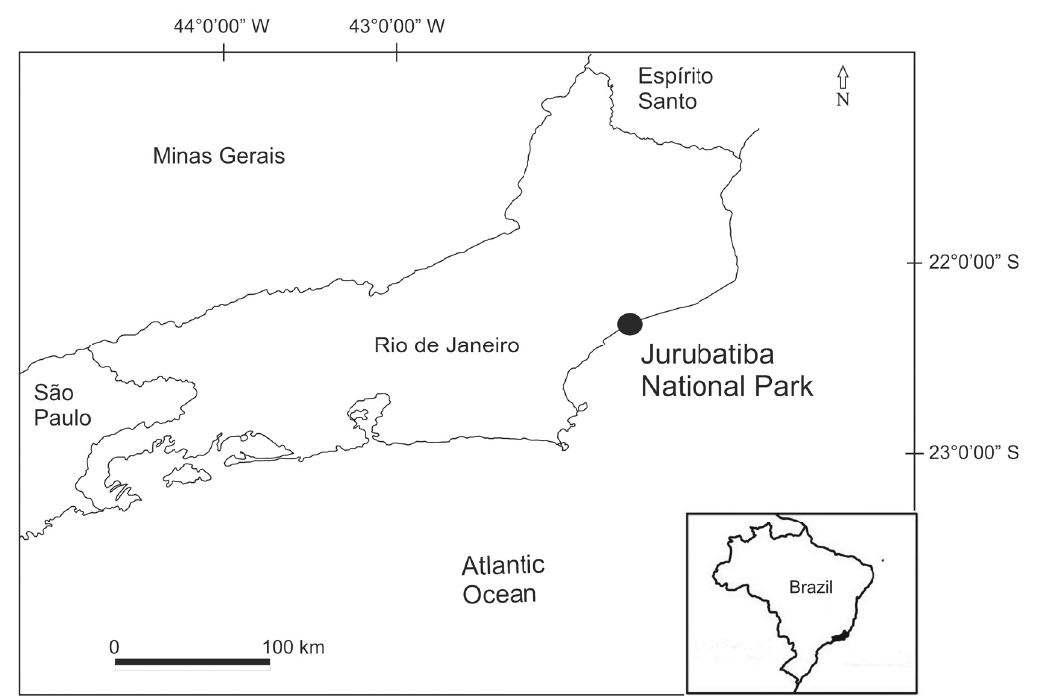
Figure 1 - Location of the Jurubatiba National Park, Rio de Janeiro state, southeastern